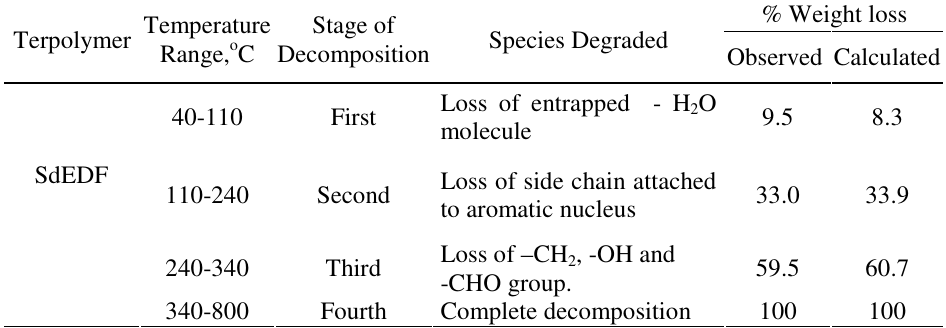
Table 1. Thermoanalytical data and decomposition temperature of SdEDF terpolymer .